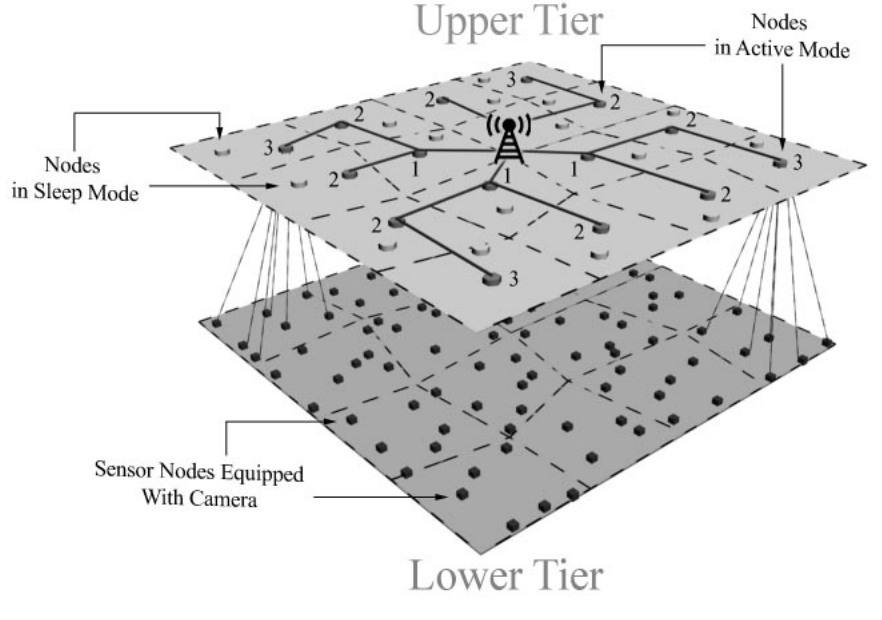
Figure 3. Symbolic figure of proposed two-tier camera-based WMSN